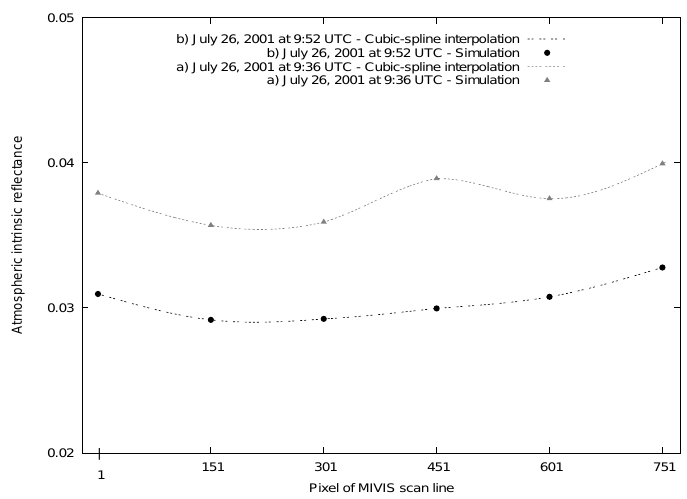
Figure 3 . The path radiance L atm , as expressed in reflectance (namely, the atmospheric intrinsic reflectance ρ atm ), simulated by the 6S code (circle and triangle) and interpolated by the cubic spline for a scan line of the MIVIS image acquired on July 26, 2001 at 9:36 UTC (grey) and at 9:56 UTC